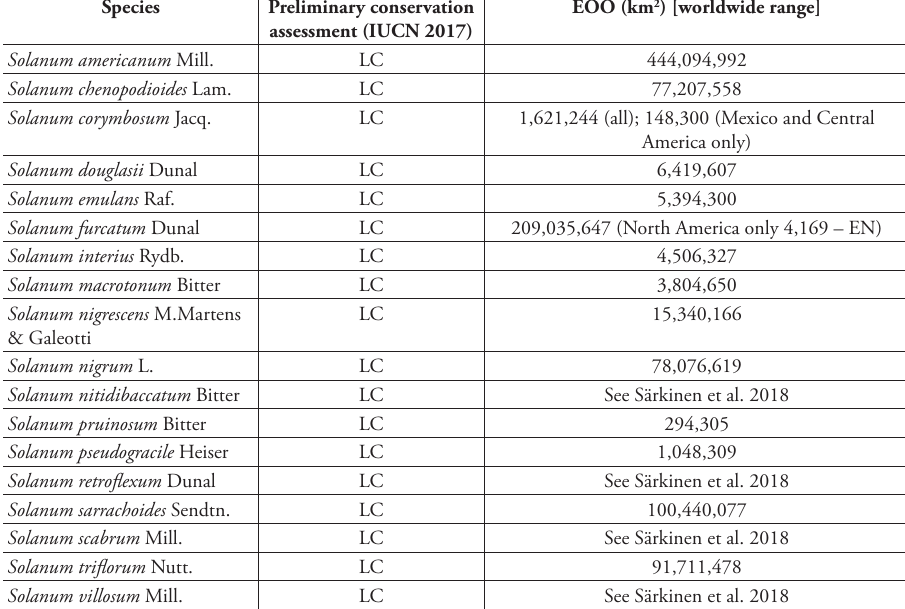
Table 6. Preliminary conservation assessments for morelloid species from the Caribbean and North and Central America. For details see Materials and Methods and individual species treatments. Preliminary assessments are based on EOO only (see Materials and Methods) and have been calculated for worldwide ranges for each species. The EOO and conservation status of species known to be solely cultivated, intro- duced or adventive in the region has been assessed in Särkinen et al.